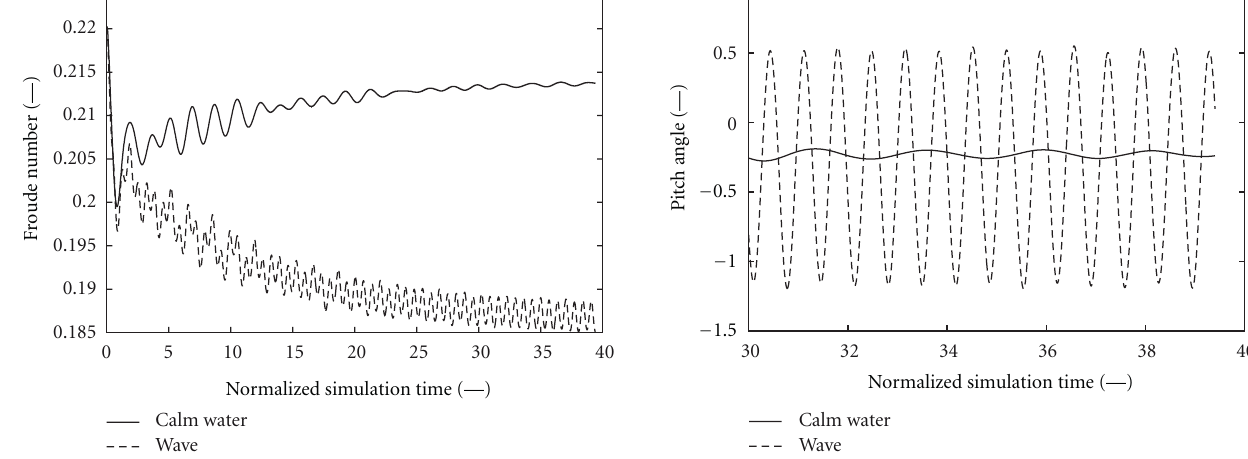
Figure 20: Pitch angle ( θλ/ (cid:14) ζ ) of the vessel during the last 10 wave periods. The solid line displays the dynamic trim of the vessel in calm water, while the dashed line depicts the pitch motions due to head waves.